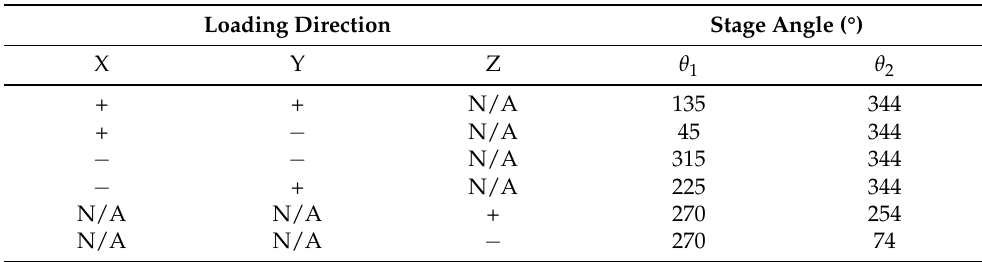
Table 3. Mapping between cardinal loading direction and angle locations on rotary stages. θ 1 and θ 2 refer to the first and second stage angles, respectively. Loading Direction